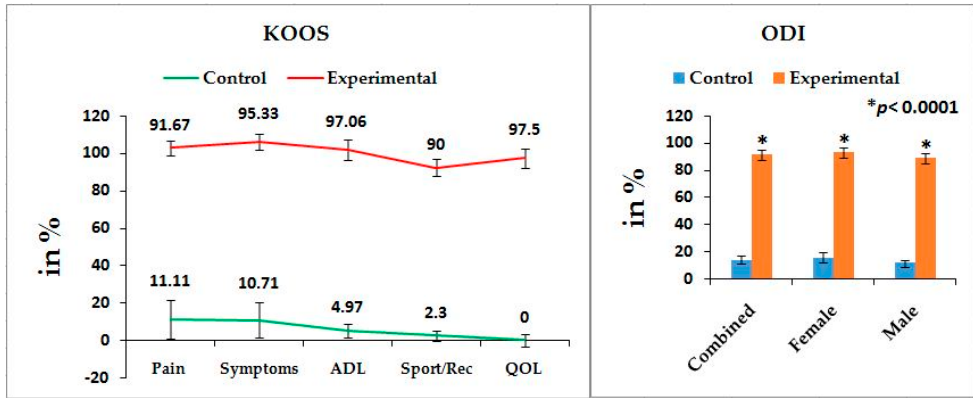
Figure 2. Graphical representation of international acclaimed pain outcome measurements under knee-injury osteoarthritis outcomes scale (KOOS) and Oswestry disability index (ODI) in comparison with control and experimental groups and their p -values.